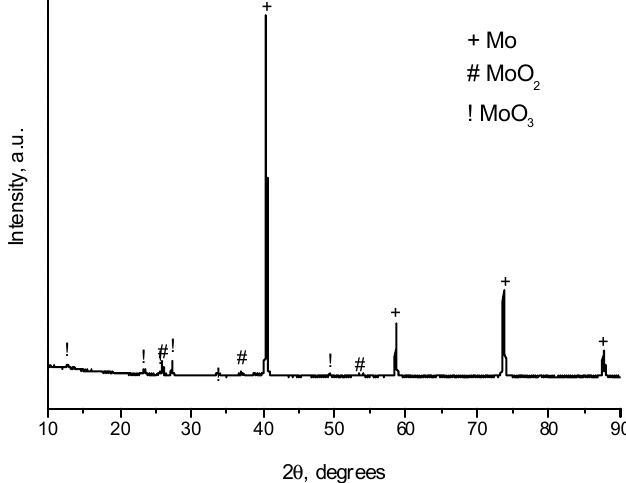
Figure 5. XRD pattern of the partially oxidized Mo powder.